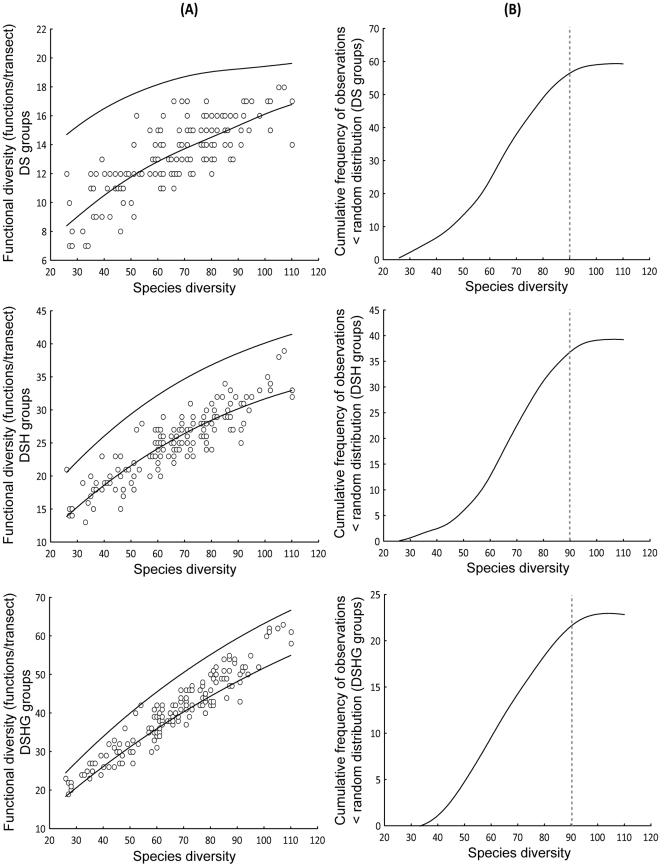
Comparing observed and random distributions of functions among species.A: Functional diversity (number of functions/transect) as a function of species diversity (number of species/transect) for the three functional classification schemes (DS, DSH, DSHG). Lines indicate 95% confidence intervals estimated from random distribution (Monte Carlo analysis with 999 permutations). B: Cumulative frequency distributions of observations for which the number of observed functions was significantly lower than the number of functions obtained from a random distribution (i.e. lower than the 95% confidence interval). DS: diet×size; DSH: diet×size×home range; DSHG: diet×size×home range×gregariousness.